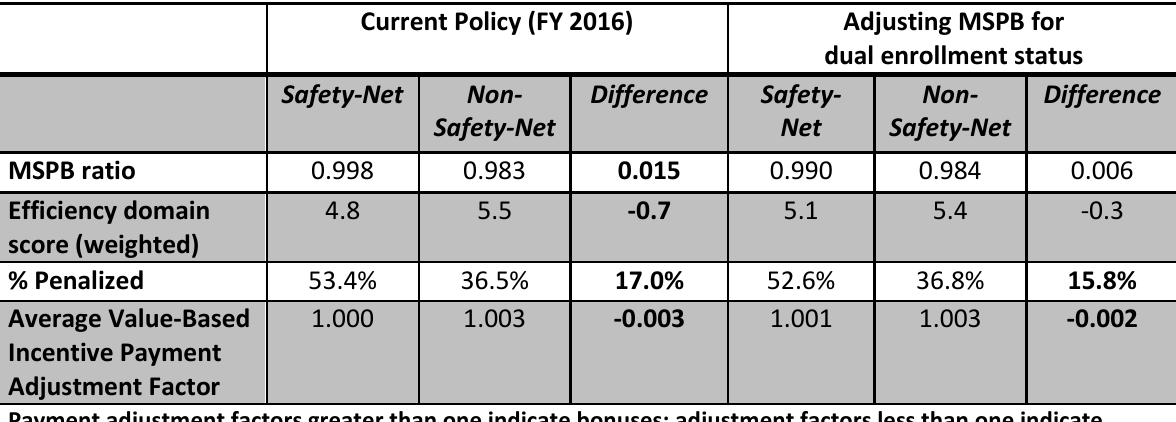
Table 7.13. Policy Option: Adjusting MSPB for Dual enrollment